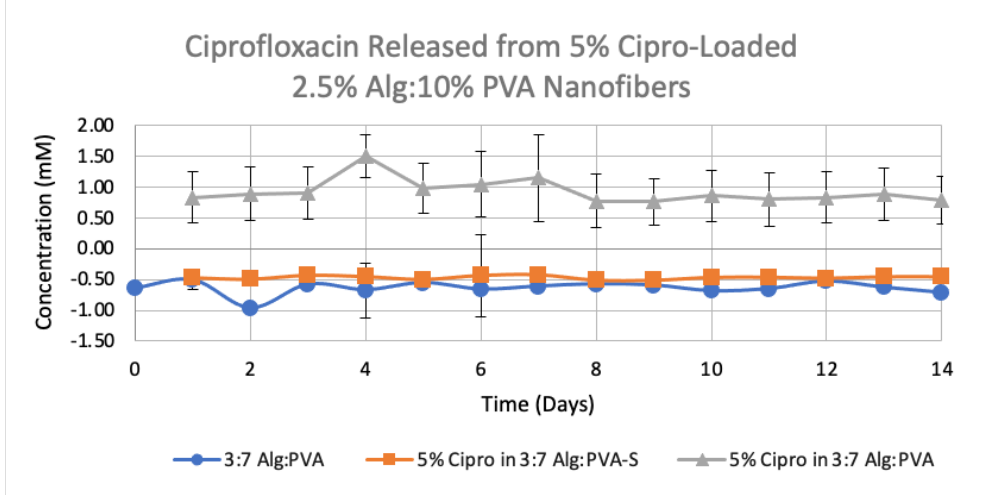
Figure 8. Comparison of average ciprofloxacin release over 14 days from two sizes of 5% Cipro-